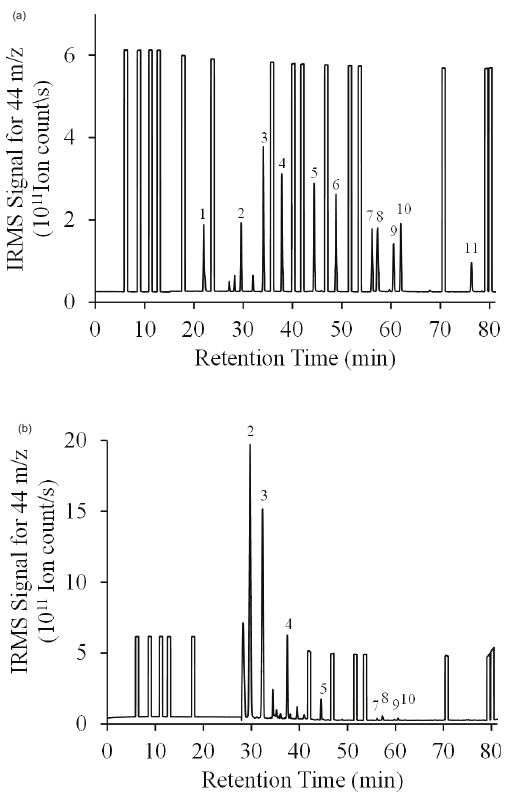
Figure 6. Chromatogram obtained by GC-IRMS for a test mix- ture with 11 compounds (a) and an ambient sample (b) . Rectan- gular peaks are reference CO 2 signals, and peaks numbered from 1 to 11 correspond to n-pentane, n-hexane, benzene, n-heptane, toluene, n-octane, ethylbenzene, p,m-xylene, o-xylene, n-nonane and n-decane.